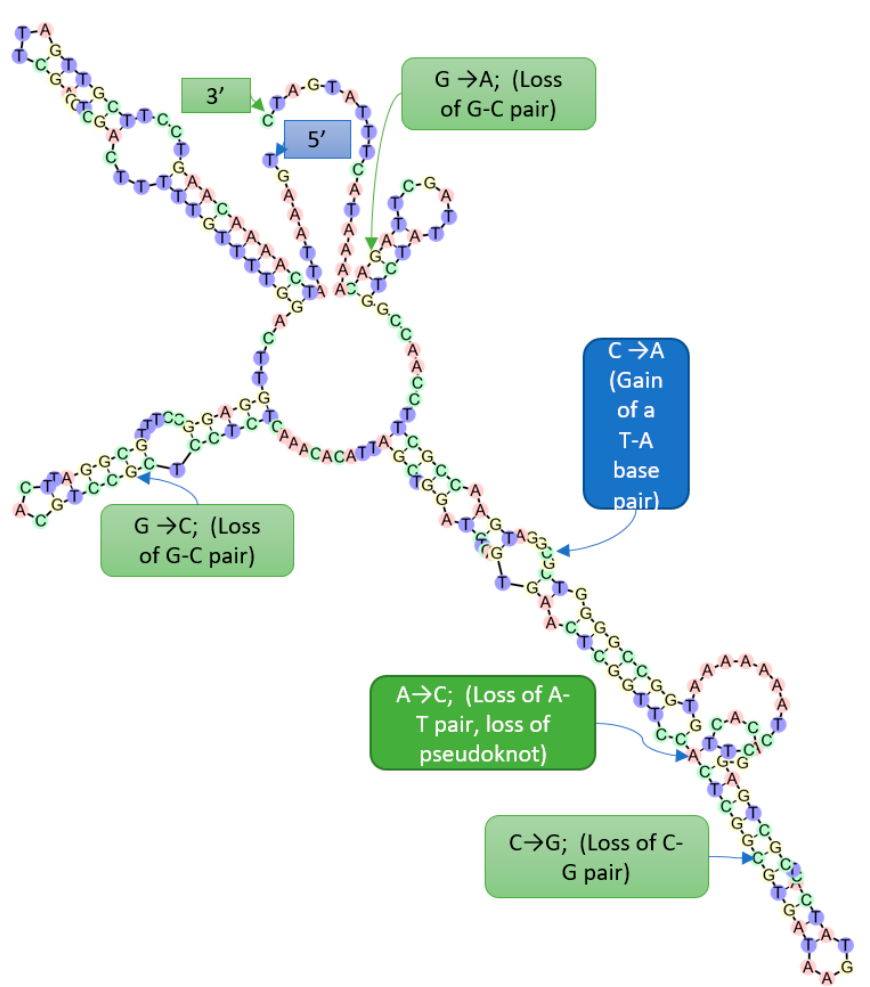
Figure 8. The ITS2 secondary structure of Rhizoctonia tuliparum isolate I-399 from Washington State (GenBank Accession KX767078), as predicted by the ITS2 DB ‘Predict’ utility. The nucleotides are highlighted in green (C), orange (G), violet (T), and pink (A). The structural changes in ITS2 of the R. tuliparum isolate 29,792 from Europe [EU19104], and the isolate CBS206.25 from New York [MH854847] are indicated as gain of a base pair due to a hemi-compensatory base change (hCBC) in the blue box and loss of base pairs due to hCBCs in the light green boxes. A hCBC resulting in loss of a pseudoknot in the isolate CBS206.25 [MH854847] is indicated in the dark green box.